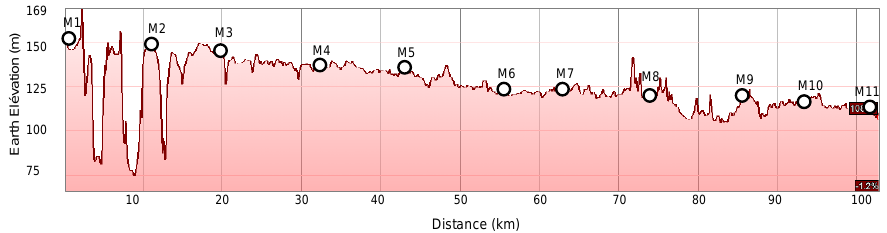
Figure 8. Terrain elevation is an important factor when selecting